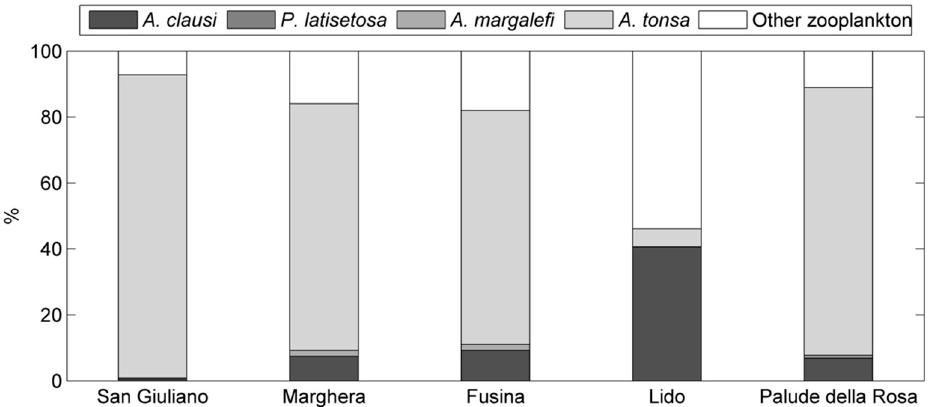
Figure 3. Relative abundance, station by station, of A. tonsa with respect to the other Acartia species and the remaining zooplankton during the 1997–2002 period.